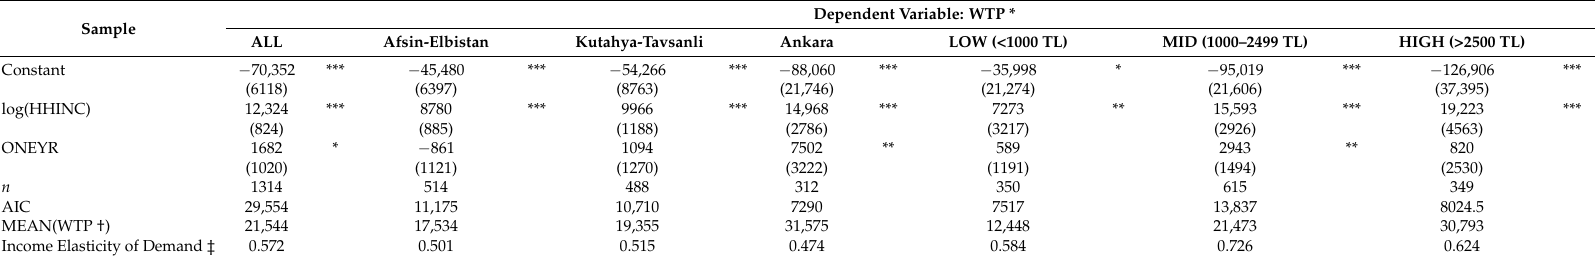
Table 10. Estimated results for income elasticity model (Model